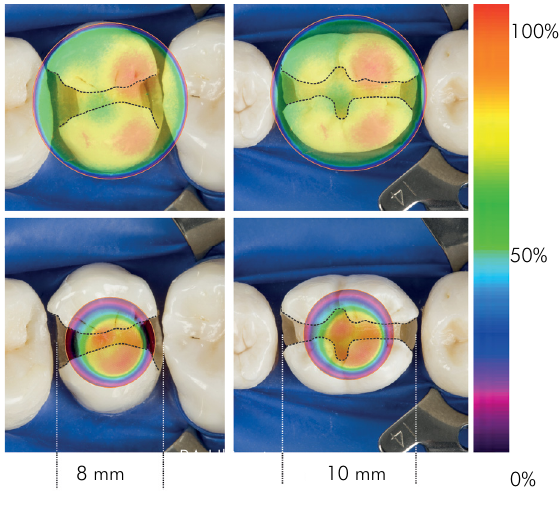
Figure 37. Clinical scenarios showing that some lights may not cover the entire